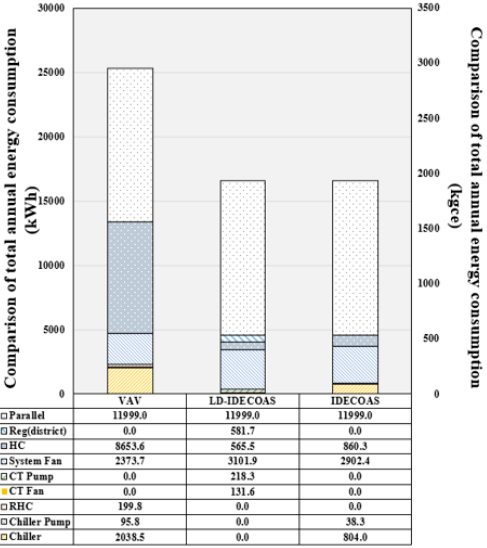
Figure 20. The total annual energy consumption of each system in the Urumqi region.